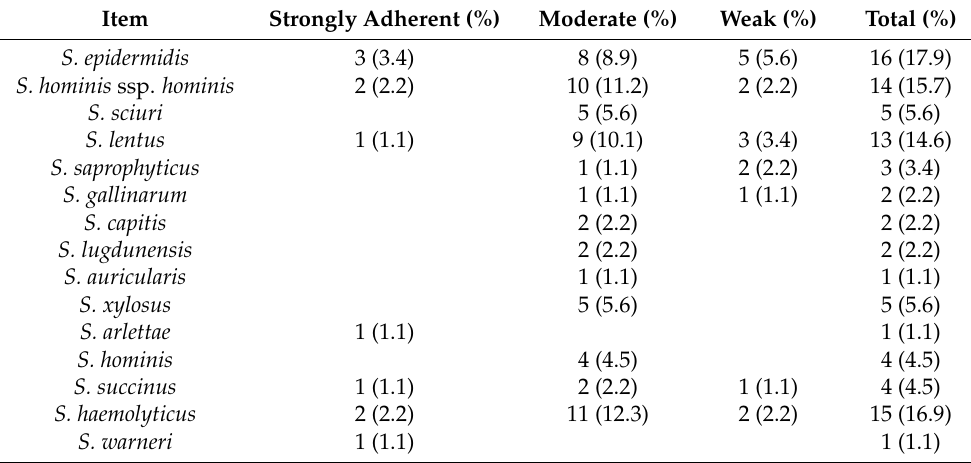
Table 1. Categories of biofilm formation according to the CoNS species obtained.